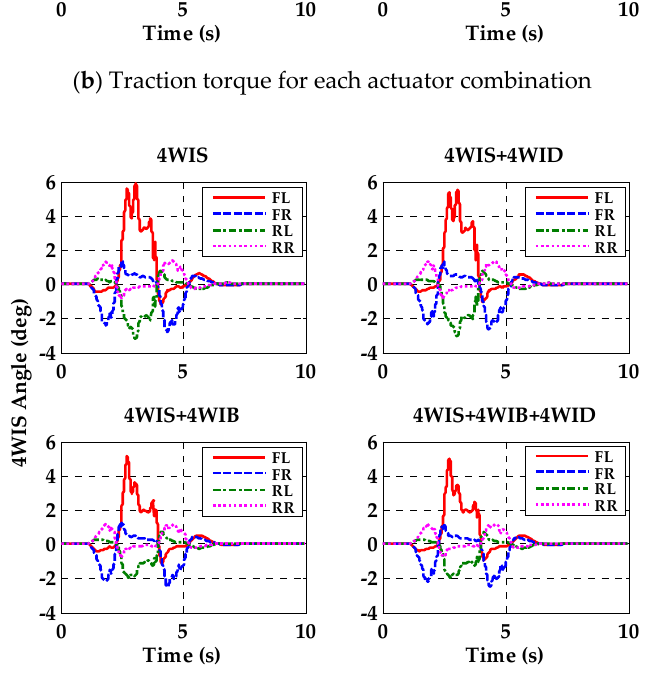
Figure 9. Control inputs of each actuator for each actuator combination.